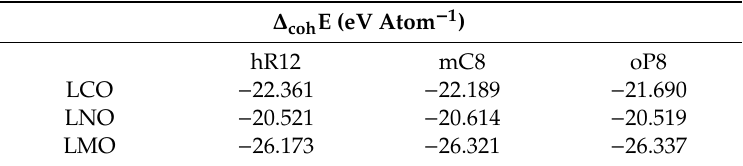
Figure 3. MO 6 octahedra for Ni-O 6 and Mn-O 6 for each hR12, mC8 and oP8 lattices. The bond distances for each M-O are reported. The red labels evidence Jahn-Teller (JT)-distortions. Color Code: Ni grey, Mn purple, O red. Table 2. Calculated cohesion energies for the LCO, LMO and LNO